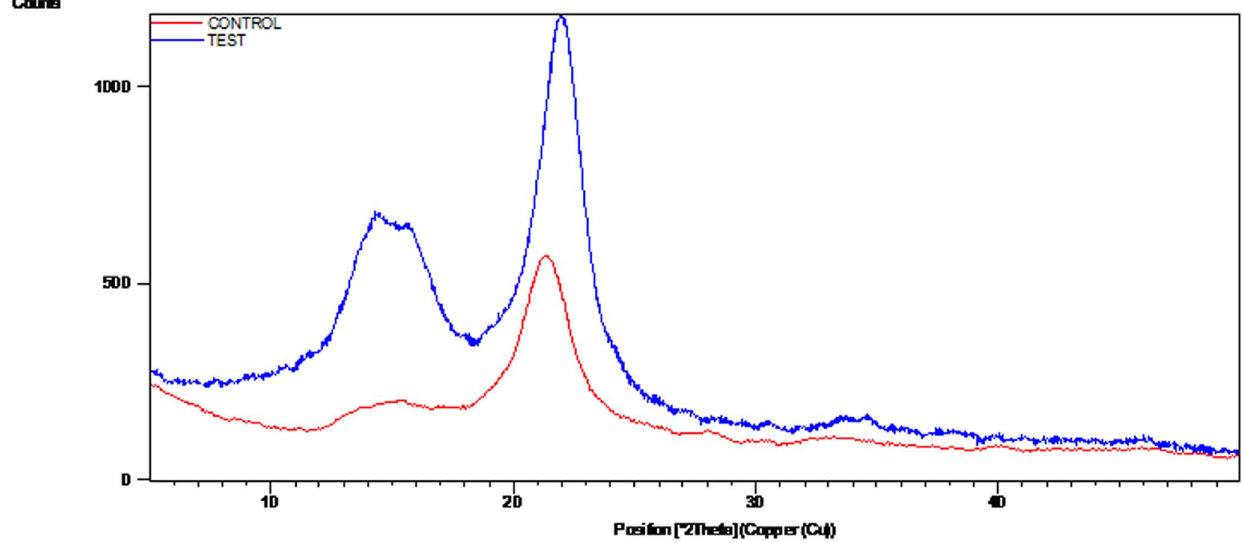
Figure 3. X-ray diffraction analysis of control (P-U-C) and test (P-X-L-C treated) ONP pulp. doi:10.1371/journal.pone.0072346.g003 PLOS ONE |